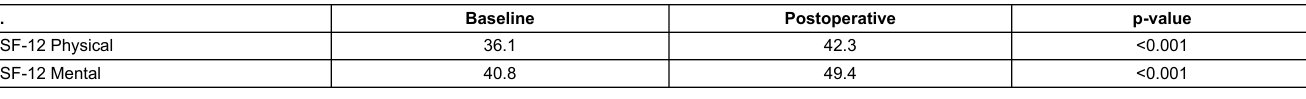
Table 6: Mean Short Form-12 quality of life outcomes (n = 34).